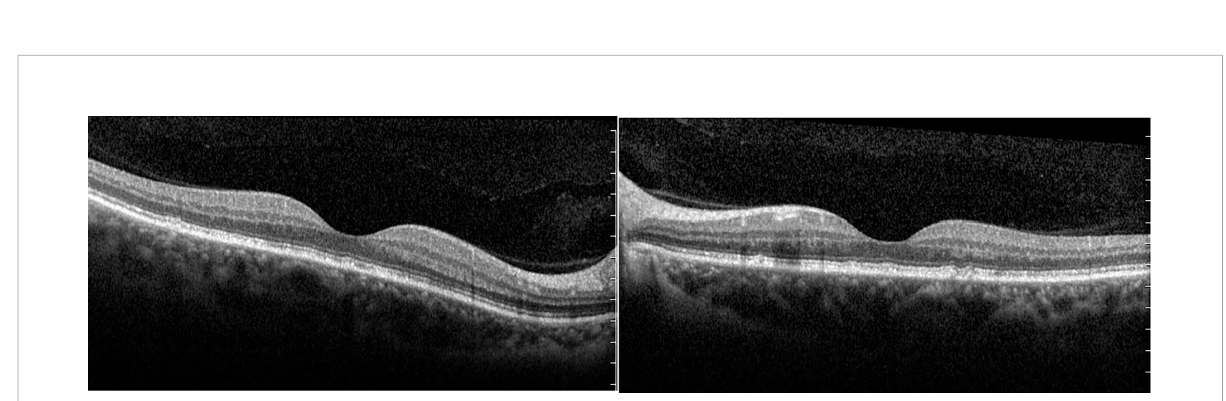
FIGURE 3 Optical coherence tomography scans of both eyes when partial remission was achieved, and visual acuity improved: (left) the right eye; (right) the left eye. Optical coherence tomography showed that serous retinal detachment had resolved completely and the macular area was equatorial in both eyes.